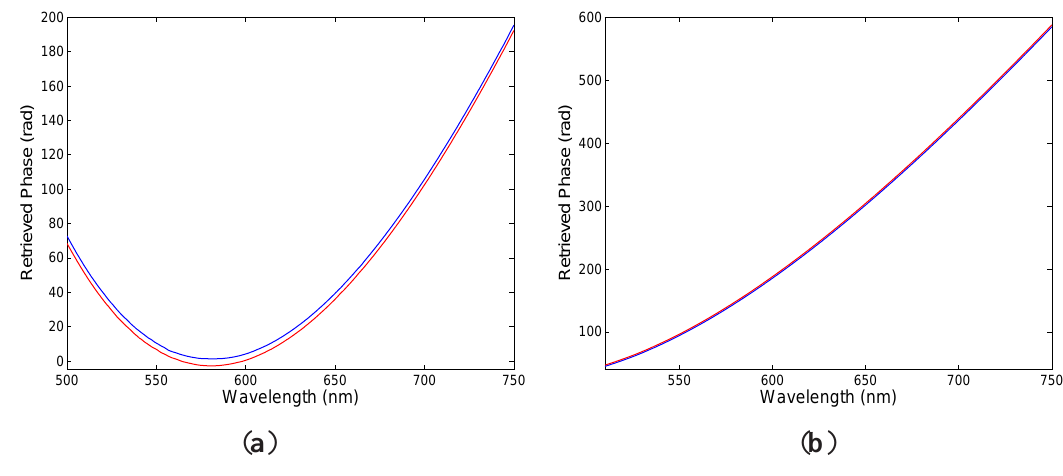
Figure 7. Retrieved phases from the recorded spectra shown in Figure 6 and corresponding to two elongations ∆ L = 100 µ m (blue) and ∆ L = 300 µ m (red) of the fiber: first 1 2 delay ( a ), second delay ( b ).